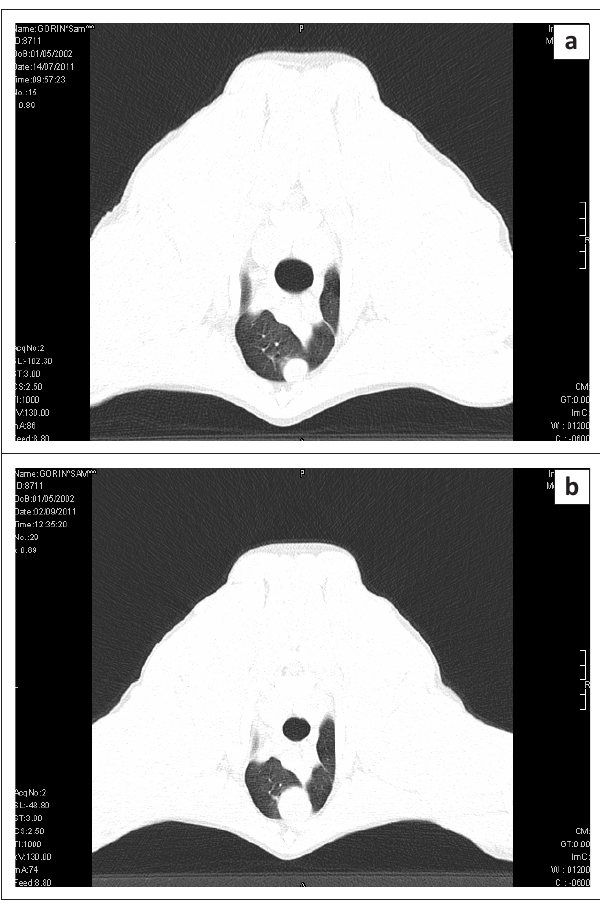
Scan performed using the lung window. FIGURE 6: Computed tomography scan of the thorax, showing progression of the metastatic nodule in the left cranio-ventral lung lobe (a) four and (b) six months after surgery.